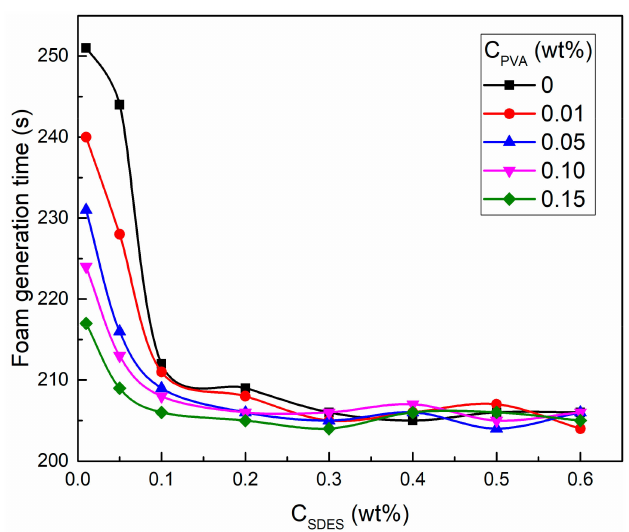
Figure 5. Foam generation time of sodium dodecyl ether sulfate (SDES) and SDES / PVA solutions.